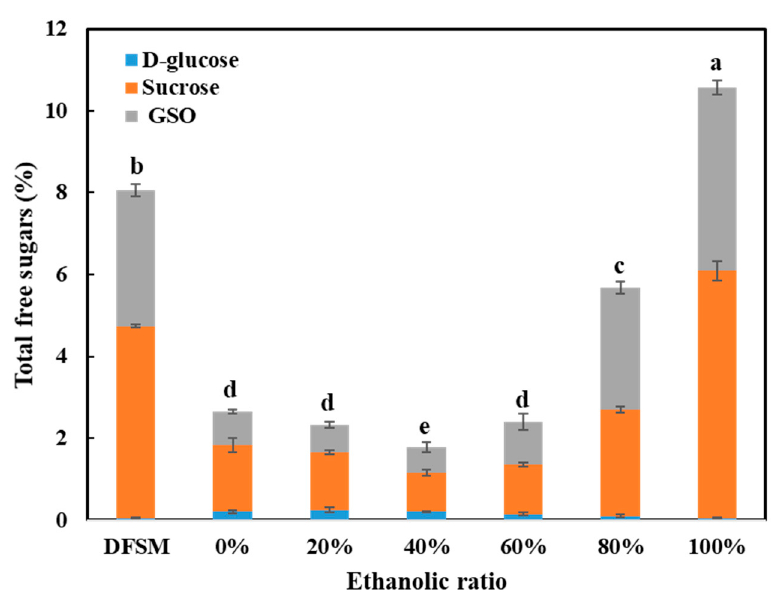
Figure 5. Total free sugars (D-glucose, sucrose, and GSO) in the defatted soy meal (DFSM) and all the soy protein concentrates (SPCs). The values in the figure are compared and different top letters (a,b,c,d,e) indicate a significant difference ( p < 0.05).